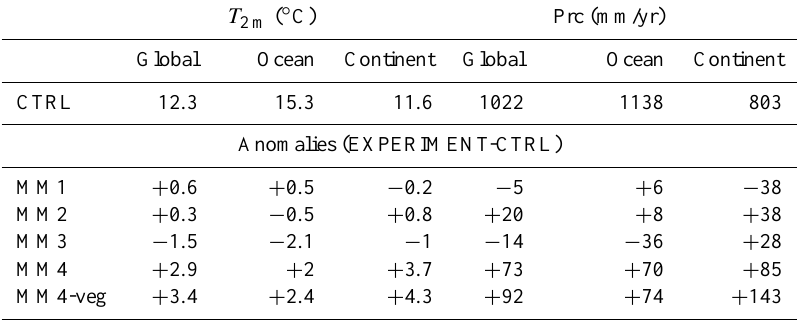
Table 2. Global, continental and oceanic annual mean near-surface temperature T 2m ( ◦ C) and precipitation (mm/yr) anomalies for the five Middle Miocene simulation experiments. The continental mean excludes the contribution from Antarctica since strong warming can be attributed due to the absence of ice that is not representative of the other effects on the continents. All results reported here are global means over the last 20years of 50-year simulations, allowing 30years for the model to equilibrate. The CTRL absolute values are shown for reference. T 2m ( ◦ C) Prc (mm/yr) Global Ocean Continent Global Ocean Continent